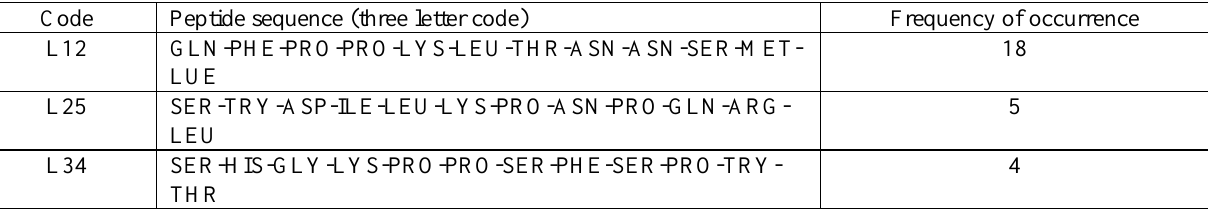
Table 1. Peptides identified with the highest frequency from the sequenced phage